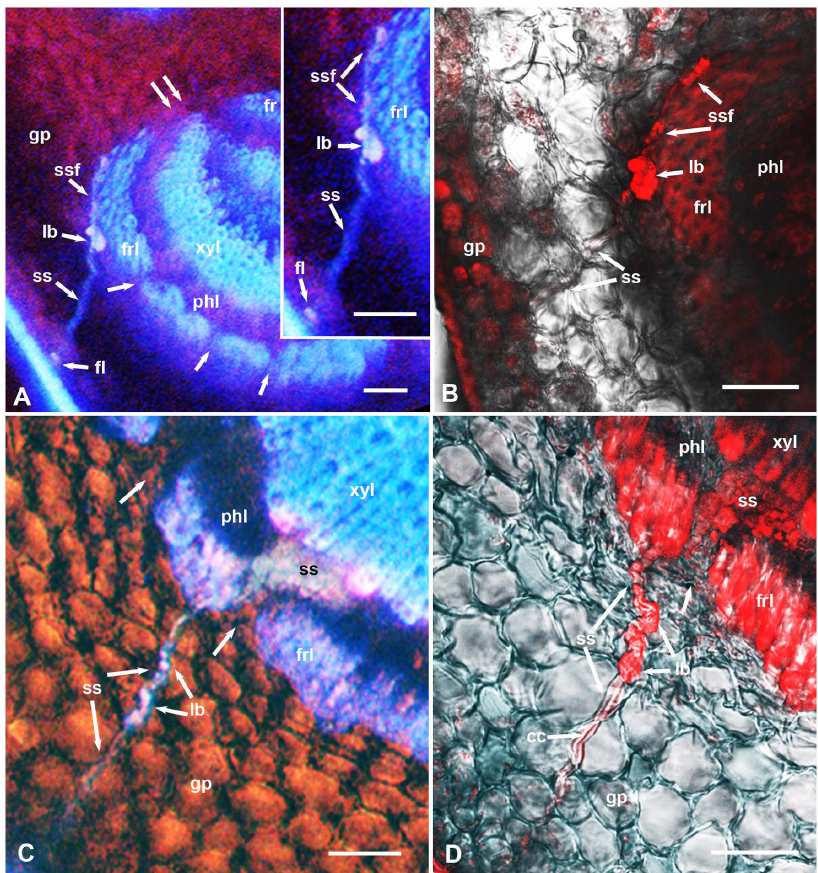
Figure 4. Stylet sheath interactions with the ground parenchyma and fibrous ring in cross sections, stained with propidium iodide, in the midrib of D.citri -resistant Poncirustrifoliata (A & B) or the relatively susceptible x Citroncirus (C & D) plants. A & C, epifluorescence microscopy images; B & D, confocal laser scanning images of the same or adjacent sections as those in A and C, respectively; differential interference contrast was also used in B–D to show cell boundaries. Unlabeled single arrows indicate smaller gaps in the fibrous ring; double arrows indicate wider gaps in this ring at the sides of the vascular bundle. Abbreviations: cc, central canal inside sheath; fl, stylet sheath flange; fr, upper fibrous ring; frl, lower fibrous ring; gp, ground/spongy parenchyma; lb, larger blebs (secretion bursts) in the stylet sheath; pc, palisade parenchyma cells; phl, lower